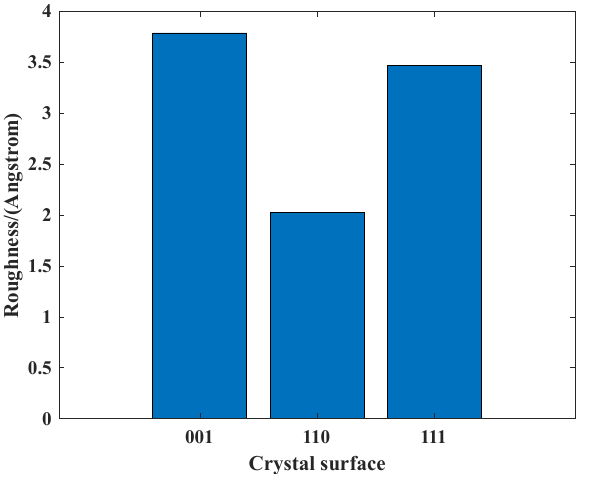
Figure 9. Roughness comparison of different crystal surfaces.